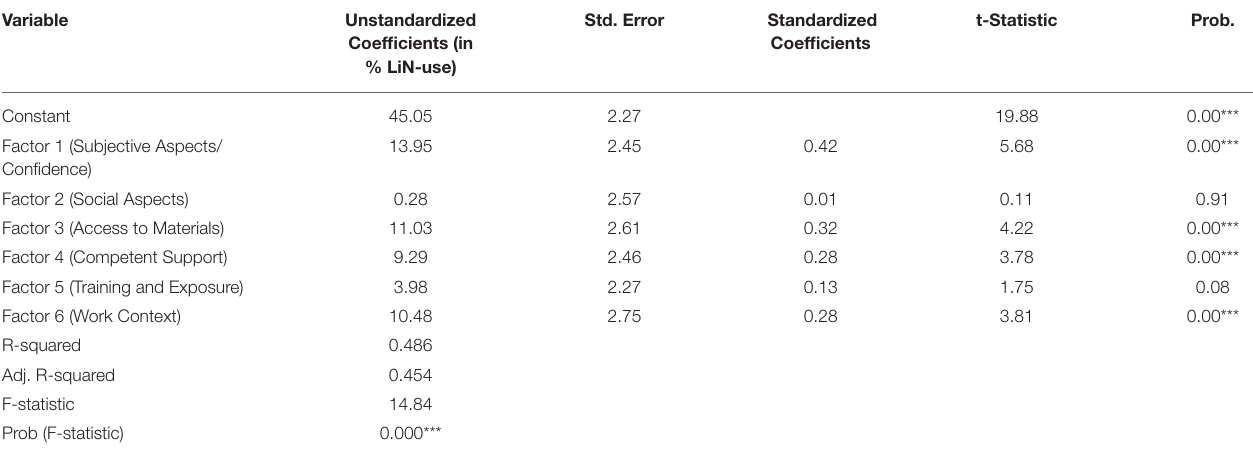
TABLE 4 | Results of ordinary least squares (OLS) regression analysis predicting LiN-use (in % of patients for whom LiN-use would be appropriate) based on factor scores.